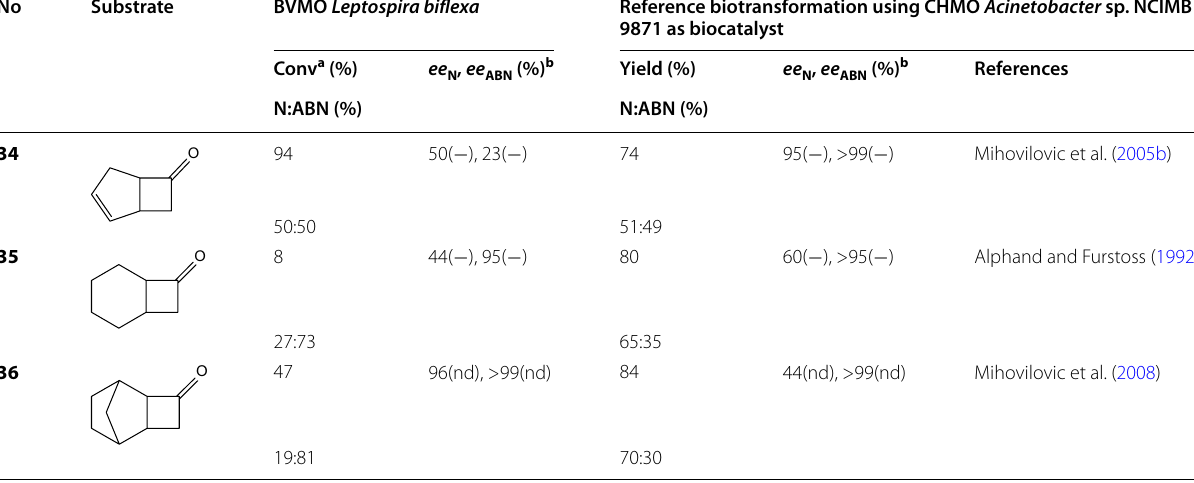
N:ABN ratio of normal:abnormal lactones, nd not determined a Relative conversion (Conv) of starting material to lactone as determined by chiral phase GC b Enantiomeric excess for normal lactone ( ee N ) and abnormal lactone ( ee ABN ). The sign of specific rotation is indicated in brackets and was assigned according to the literature for reference biotransformations